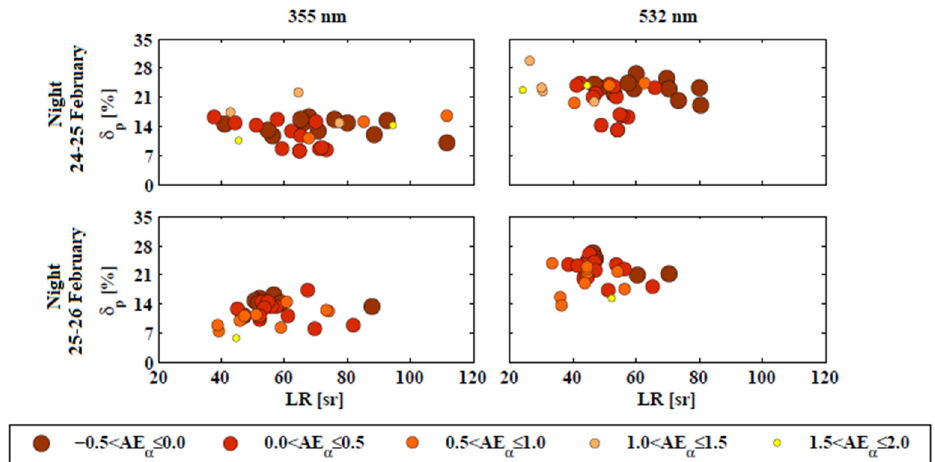
Figure 4. Mean values of LR, δ , and AE calculated within selected aerosol layer for the profiles obtained during the nighttime measurements between 24–26 February 2022. Size of the points corresponds to the particle size (legend below the plot). Obtained values may suggest the presence of mineral dust with other aerosol admixtures.